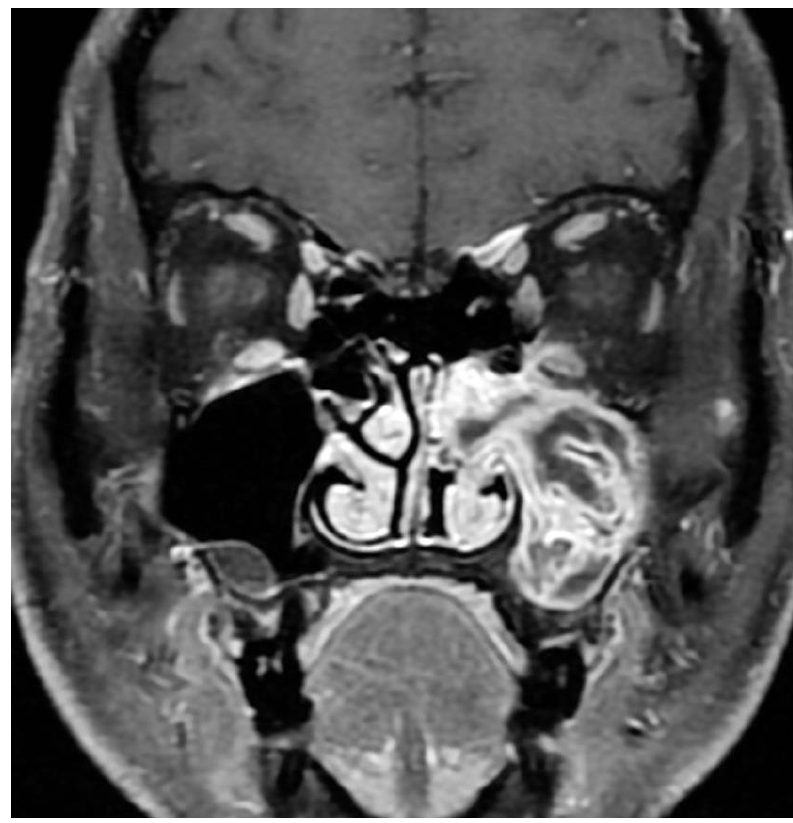
Figure 3. Alternating lines of high and low signal intensity (convoluted cerebriform pattern) seen in an inverted papilloma of the maxillary sinus.